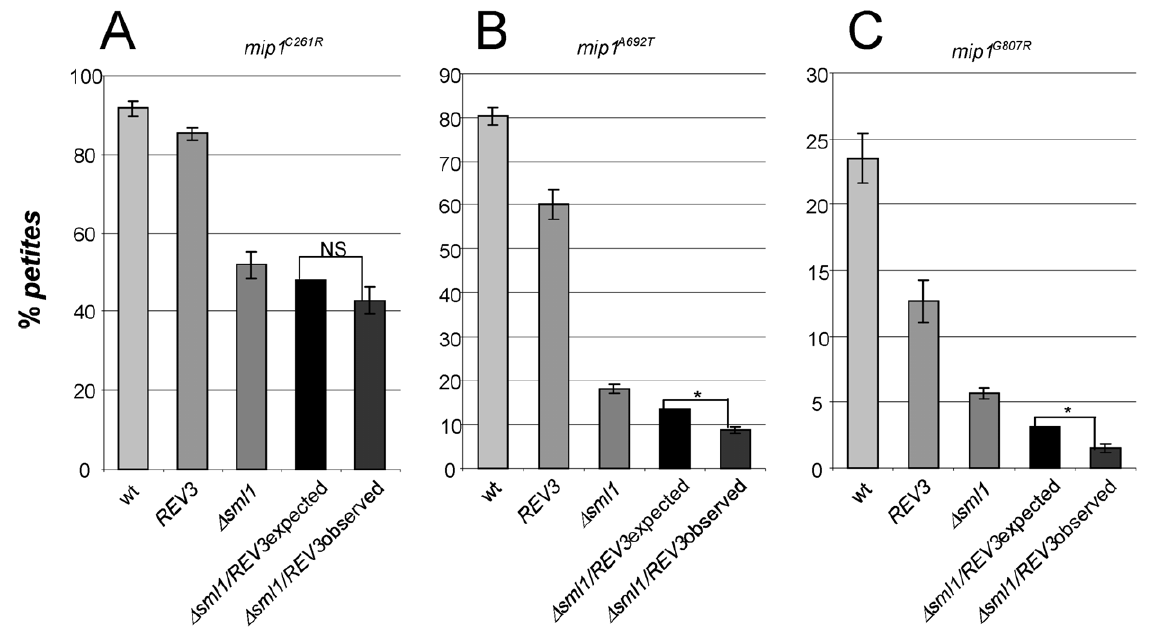
Figure 6. Petite frequency of mip1 C261R , mip1 A692T and mip1 G807R strains disrupted in SML1 and overexpressing REV3 . In each graph the following petite frequencies are reported: mip1 strains transformed with YEplac195 empty plasmid (wt) or with YEPlac195- REV3 ( REV3 ); mip1 sml1 D strains transformed with YEplac195 empty plasmid ( sml1 D ) or with YEplac195- REV3 ( sml1 D / REV3 observed). In addition, the penultimate bar represents the petite frequency of sml1 D strain transformed with YEplac195- REV3 that would be expected if the effects of the overexpression of REV3 and of the deletion of SML1 were additive ( sml1 D / REV3 expected). * indicates that the observed frequency is significant lower than the expected one. NS: not significant.